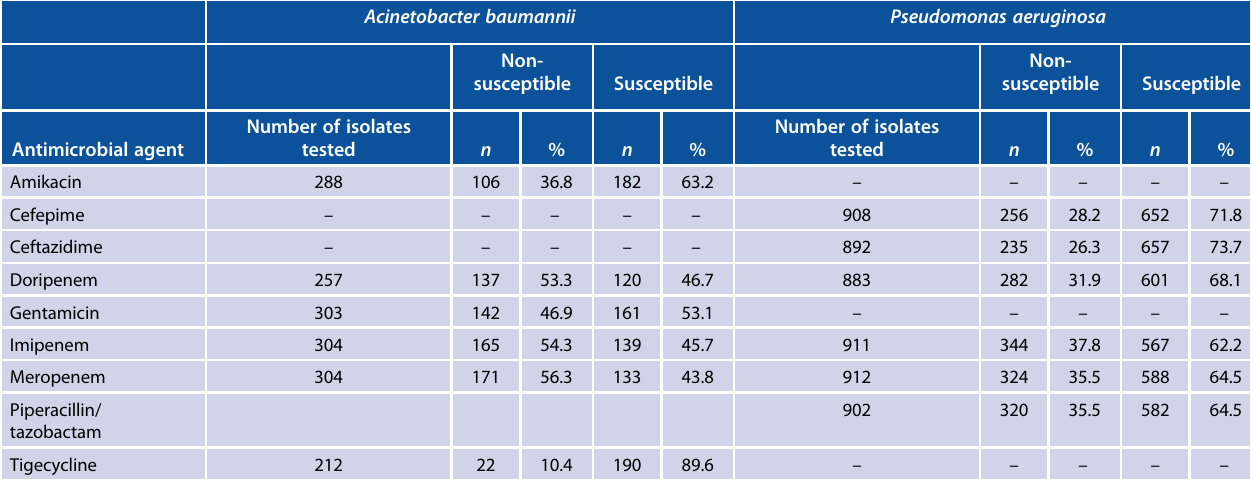
Table 2: Antimicrobial susceptibility patterns of non-fermenters isolated from blood cultures reported from four private groups in South Africa, January 1, 2016 to December 31, 2016